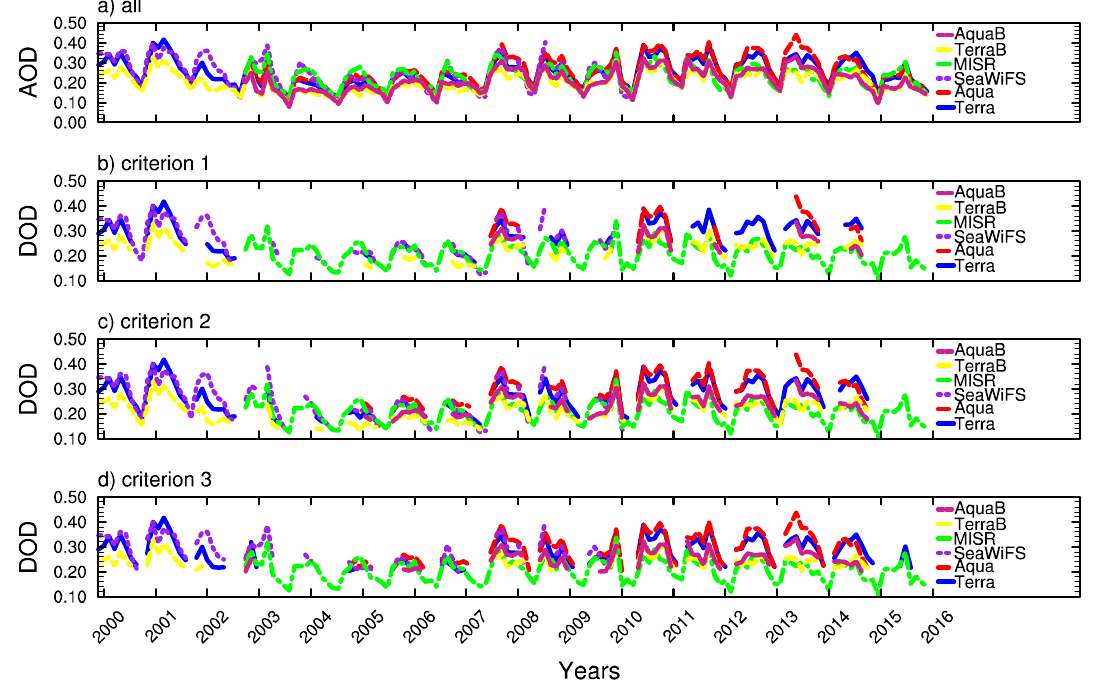
Figure 6. Interannual variability of AOD ( a ); and dust AOD with the three criteria given in Table 1 ( b – d ) for the 2000–2016 (Terra), 2003–2016 (MISR), and 2000–2010 (SeaWiFS) periods over western Central Asia. TerraB and AquaB represent best estimate with quality flags = 2 or 3.